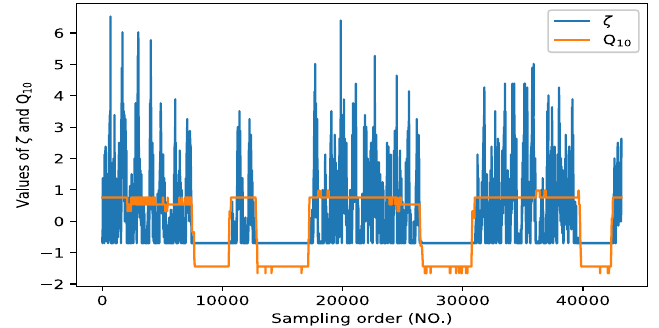
Figure 2. Correlation coefficient between ξ and Q 10 .